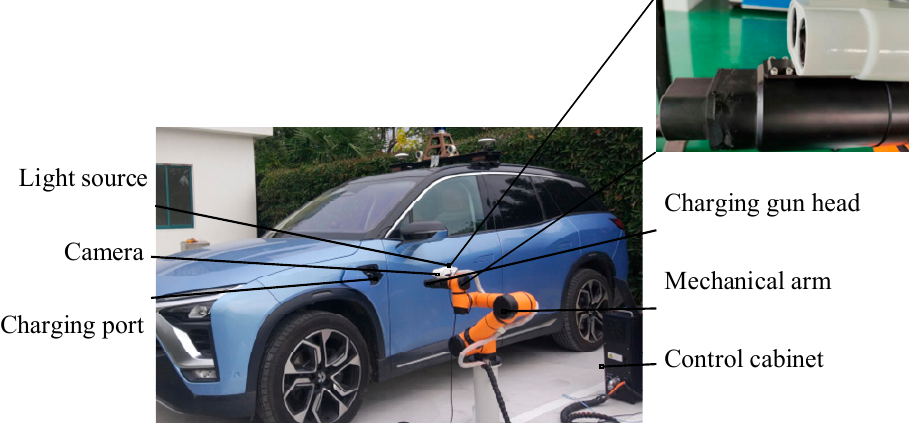
Figure 1. Automatic charging system experimental platform. Table 1. Detailed information of